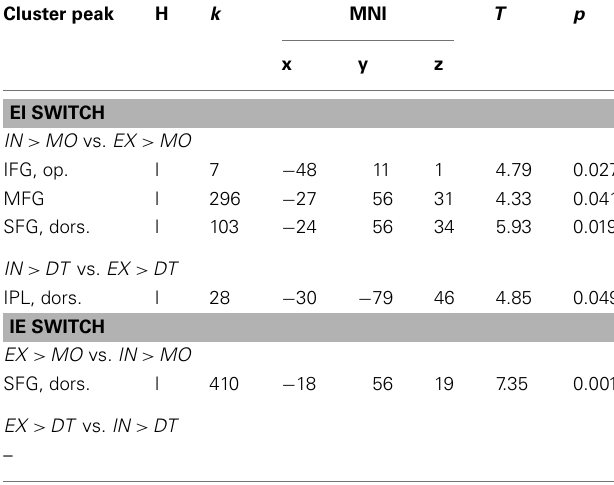
Table 2 | Overview of significant results of the ROI-analysis for the within-group comparisons of the two experimental groups ( α < 0.05, p -values are FWE-corrected , cluster size threshold k >